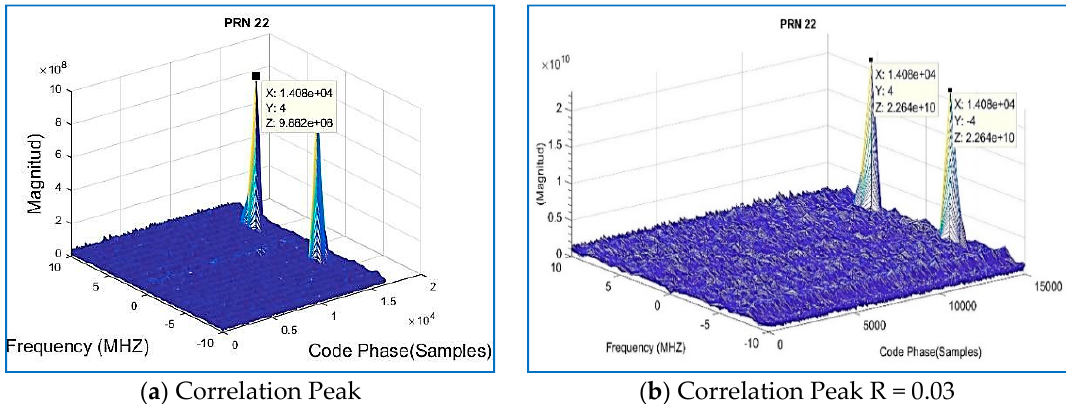
Figure 14. Recorded real signal Dataset 2: ( a ) the correlation peak; and ( b ) the correlation peak of the GPS signal when the signal is compressed with R = 0.03.